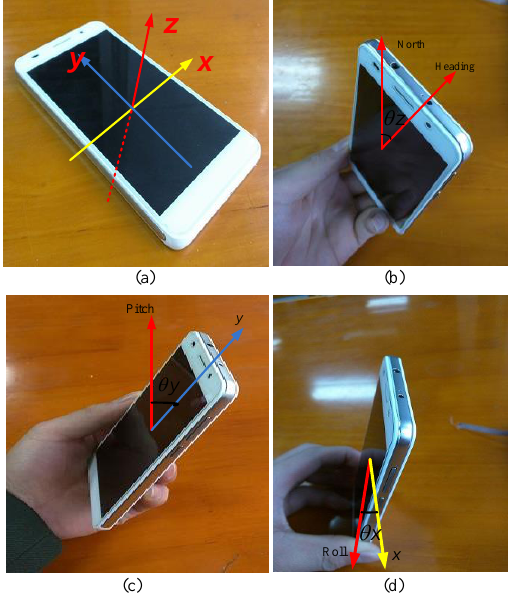
Figure 4. ( a ) The coordinate system in a smartphone; ( b ) heading indication of a smartphone; ( c ) pitch indication of a smartphone; ( d ) roll indication of a smartphone.